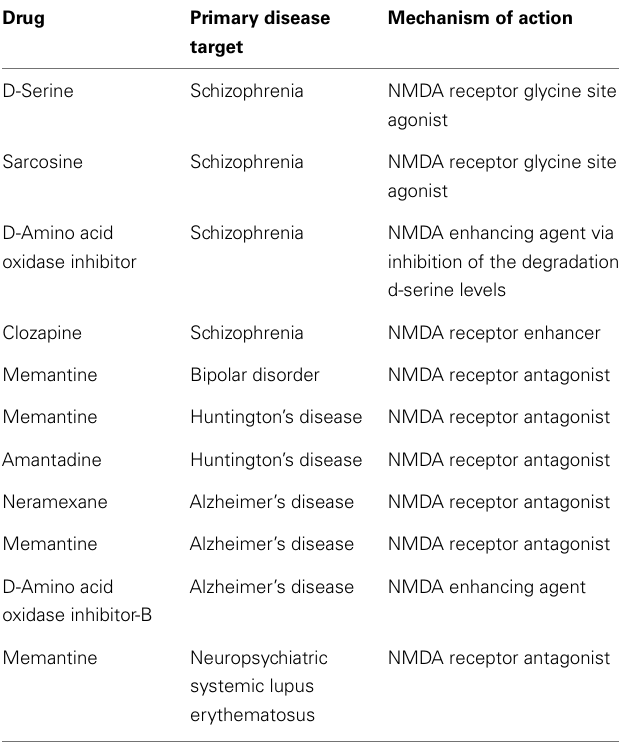
Table 1 | Select NMDA receptor-targeted drugs used in clinical trials for the treatment of mental